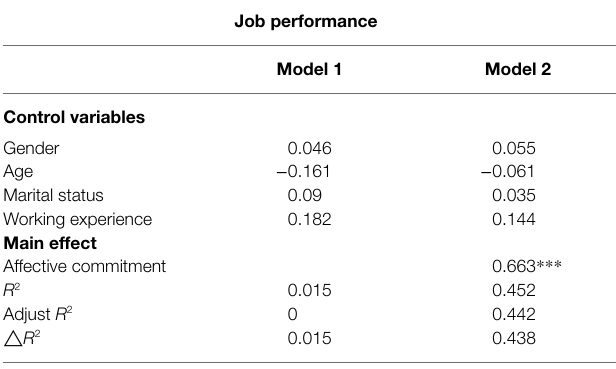
TABLE 6 | Regression analysis of affective commitment and job performance.